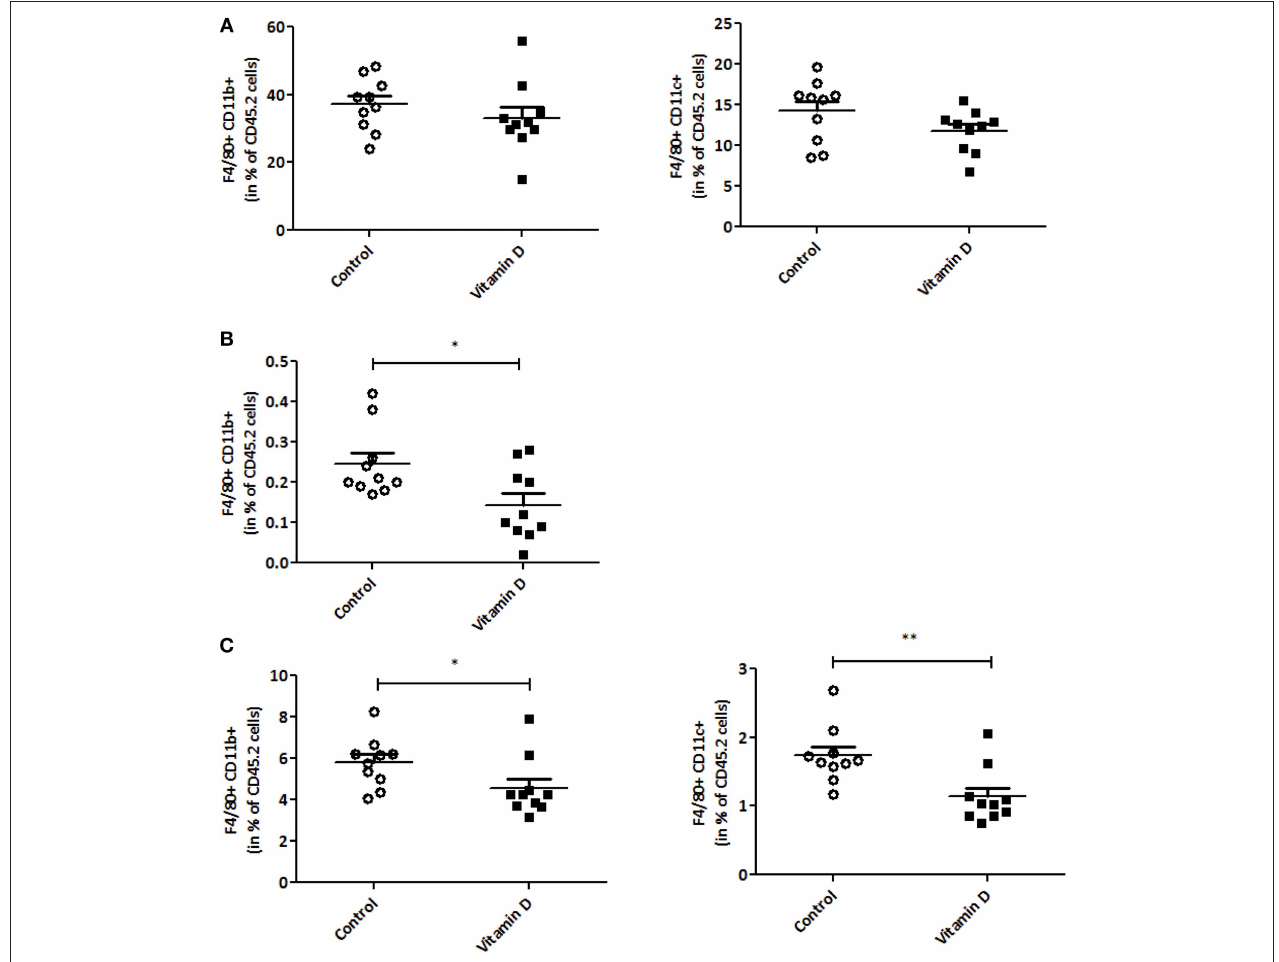
FIGURE 4 | Vitamin D modulates macrophage infiltration. Frequencies of macrophages “F4/80 + CD11b + ” and “F4/80 + CD11c + ” were analyzed by flow cytometry in tumor (A) , tumor-draining lymph nodes (B) and spleen (C) ( n = 10). The values are presented as the mean ± SEM. * P < 0.05, ** P < 0.01 compared with control group fed with standard